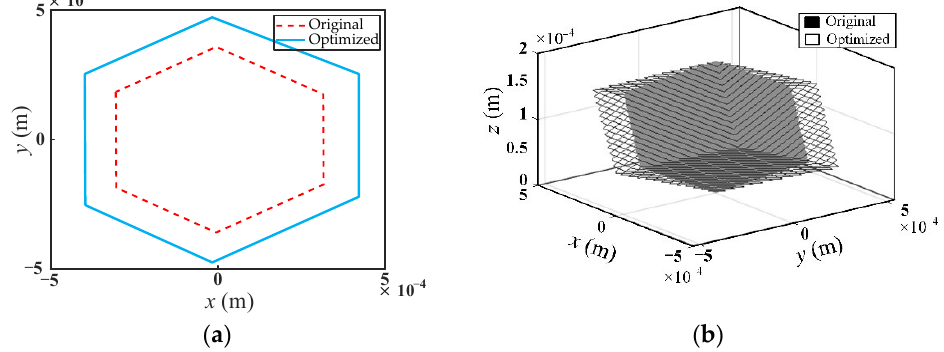
Figure 15. Comparison of the workspace between original and optimized mechanism, ( a ) the maximum cross-section of the workspace of the mechanism; ( b ) micromanipulator workspace.